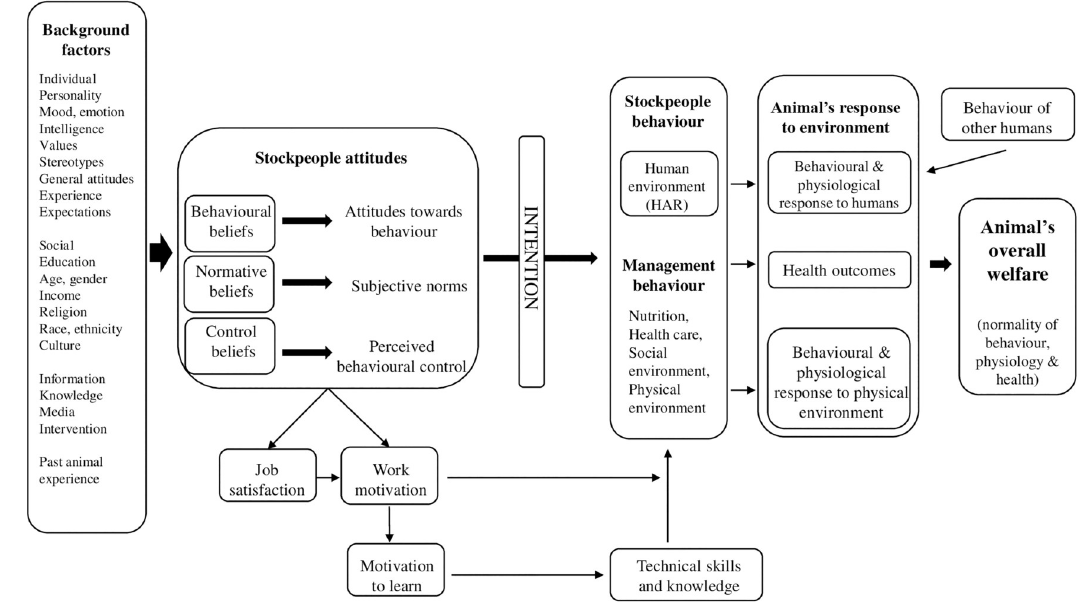
Fig 1. The Human-Animal Relationship Model based on the Theory of Planned Behaviour adapted from